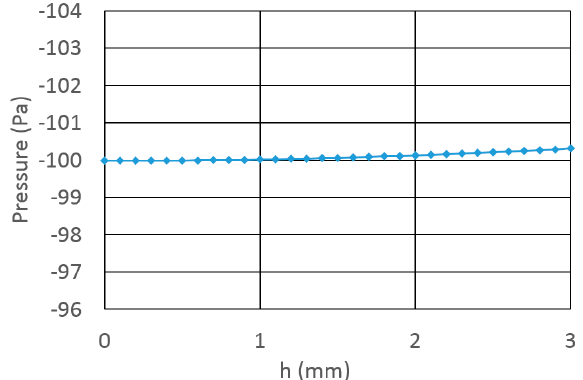
Figure 3. The pressure dependence on fluid level h . Negligible variation in the pressure (~0.3%) is predicted.